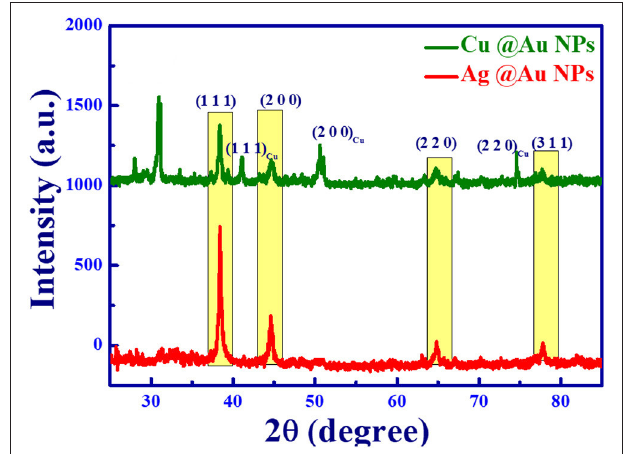
FIGURE 2 | X-ray diffraction spectra of synthesized Ag@Au (Bottom) and Cu@Au (Top) NPs.